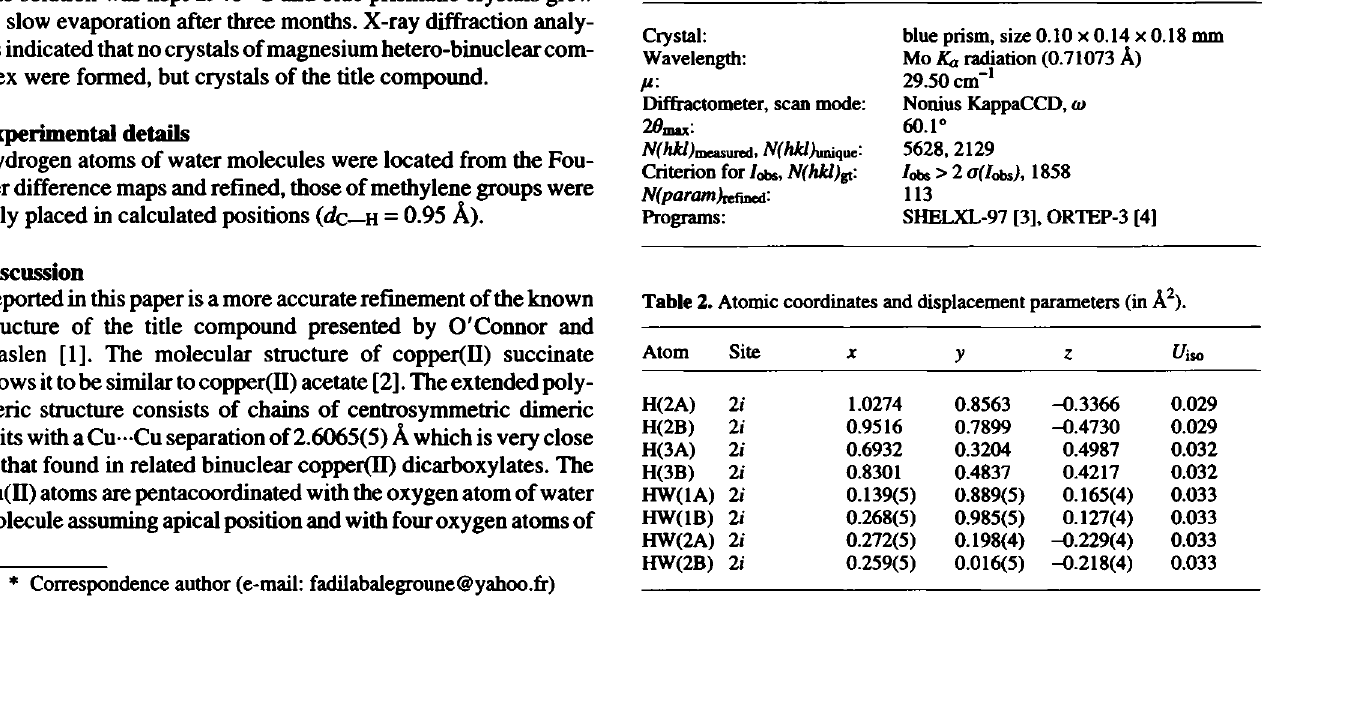
Table 1. Data collection and handling.